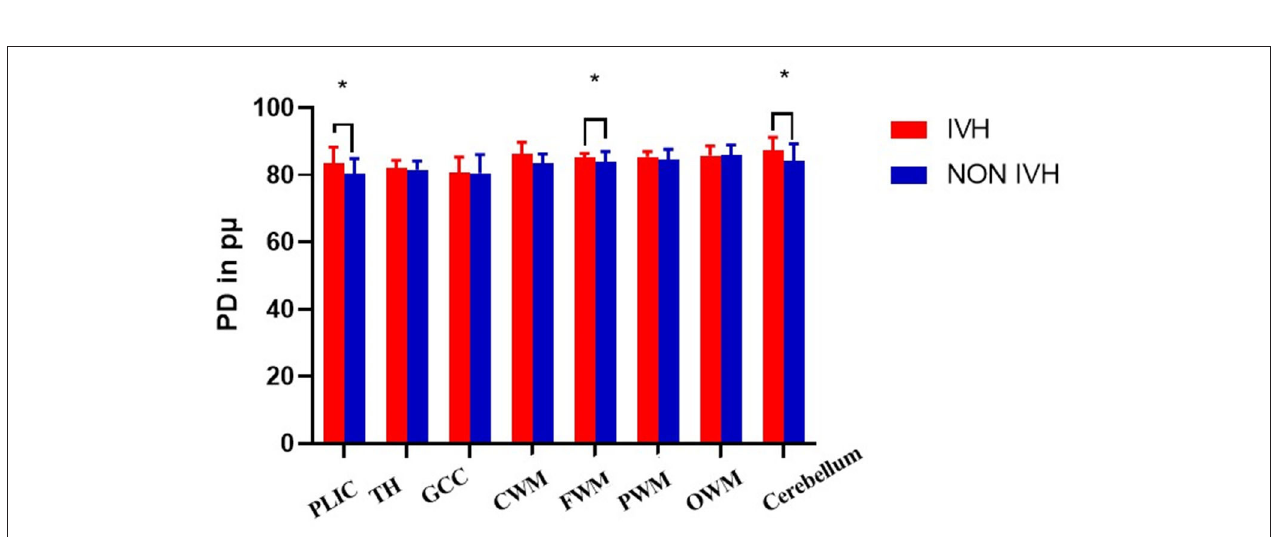
FIGURE 4 | Differences in PD values between IVH and NON IVH groups. The IVH group is displayed in red and the NON IVH group in blue. PLIC, posterior limbs of the internal capsule; TH, thalamus; GCC, genu of the corpus callosum; CWM, Central white matter; FWM, frontal white matter; PWM, parietal white matter; OWM, occipital white matter. * p < 0.05,** p < 0.001.